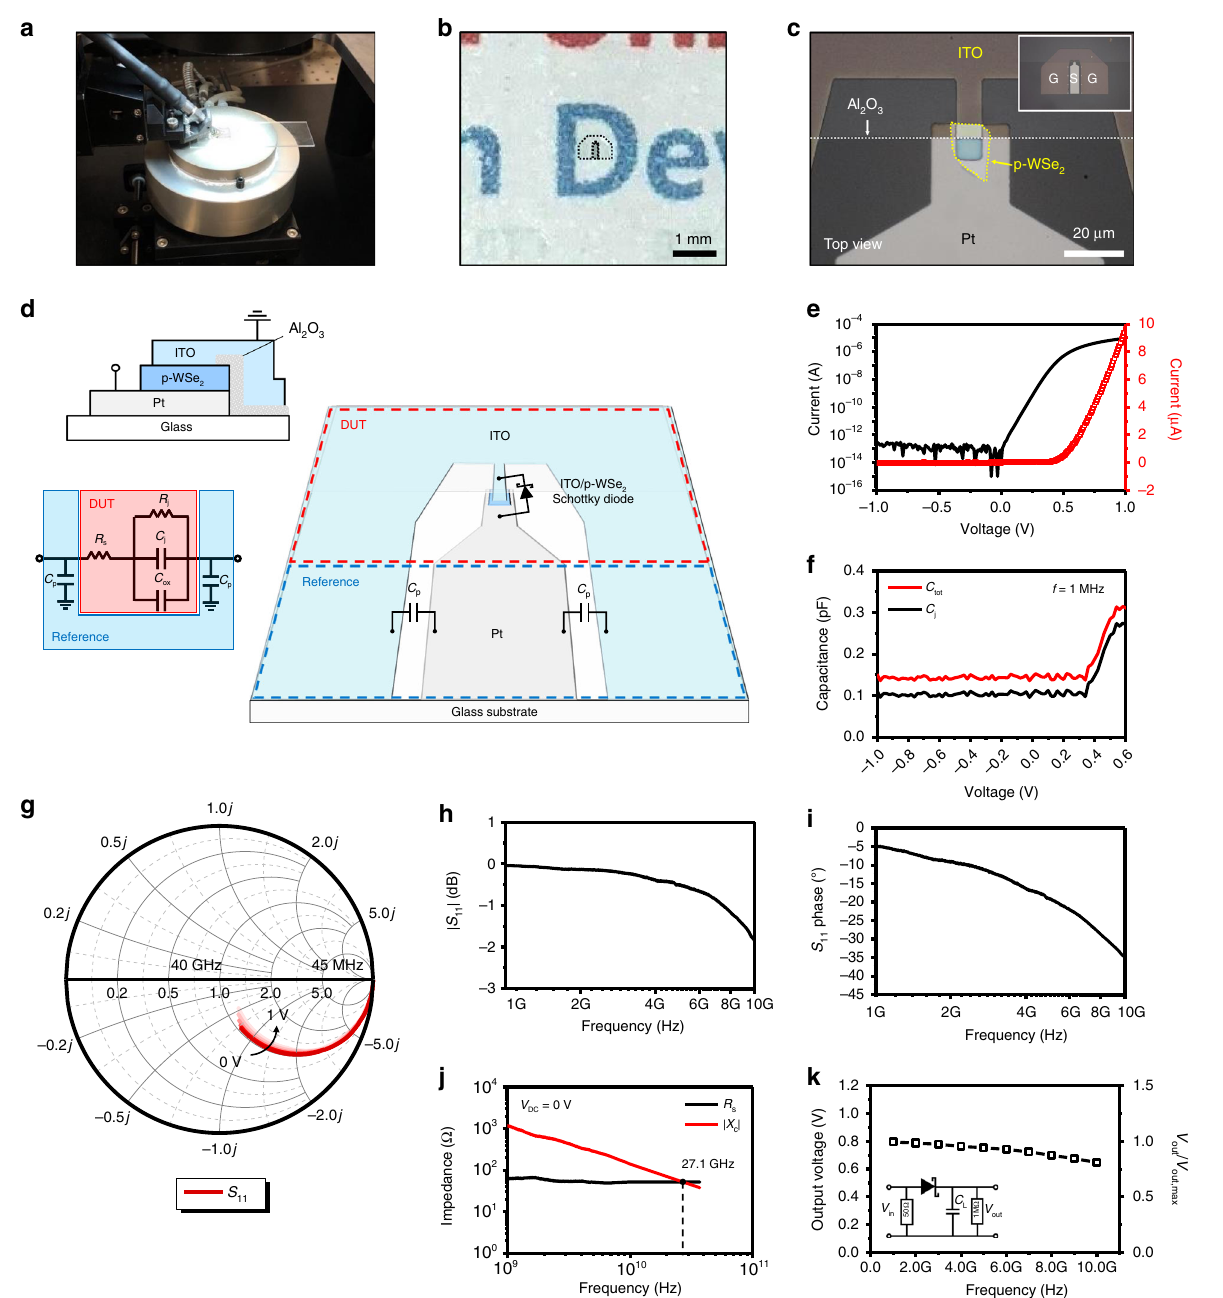
Fig. 3 Semitransparent ITO/p-WSe 2 Schottky device architecture for RF measurements. Photograph of RF probing ( a ), OM image of our device showing semitransparency on a background paper ( b ), magni fi ed OM image without background paper ( c ), and CPW con fi guration ( d ) of the Schottky diode prepared on the G-S-G pattern. The inset OM image of c is a zoomed image of the device in b . The top and bottom insets of d are a 2D cross-section schematic and an equivalent small signal model of the Type B diode for the high frequency RF measurement. R s , R j , C j , and C ox are noted in the circuit model. The parasitic capacitance ( C p ) can be negligible compared with C ox and C j . I – V ( e ) and C – V ( f ) characteristics of the ITO/p-WSe 2 Schottky diode. Both of approximate C j and C tot ( = C j + C ox ) with parallel Al 2 O 3 are displayed. g Smith chart from 45 MHz to 40 GHz under forward DC biases (0 to + 1 V) as obtained from S 11 parameter measurement. As a positive voltage is applied, the red curve goes inward. Magnitude ( h ) and phase angle ( i ) plots of S 11 parameters in the Schottky device. j R s and | X c |( = 1/ ω C tot ) plots as a function of frequency at 0 V (battery free). The cutoff frequency is found at 27.1 GHz. The plots are without de-embedding. k Average recti fi ed V out as a function of frequency of the input AC signal with an amplitude of 1 V. Inset circuit is for recti fi ed DC output voltage measurements. According to h , j , and k , cutoff frequency should be much higher than 10 GHz and approaches to ~27 GHz. order of magnitude (or 12 times) smaller (the inset of Fig. 1a). OFF ratio (~10 7 ) along with an improved ideality factor of 1.12. Figure 3e shows the I – V characteristics of the Type B diode, All of these positive effects should be related to the reduced showing much improved DC properties compared with those of junction and oxide-capacitive area. Moreover, such a reduced the Type A device: three orders of magnitude lower reverse junction area leads to smaller junction capacitance (0.10 – 0.12 pF) leakage current (110 fA) and two order of magnitude higher ON/ as well as the total capacitance. The C – V characteristics in Fig. 3f NATURE COMMUNICATIONS| (2020) 11:1574